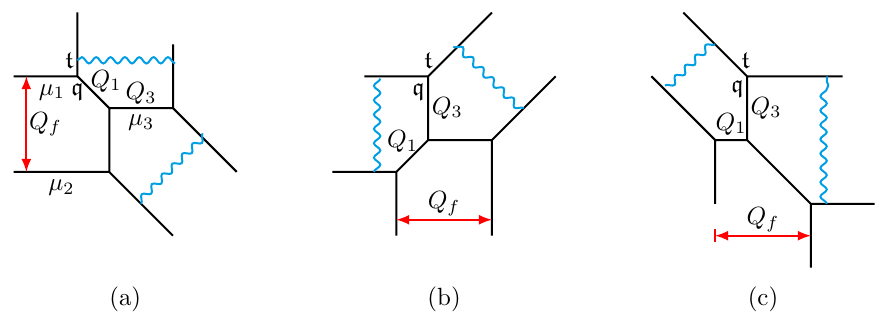
Figure 13 . Sources of the extra